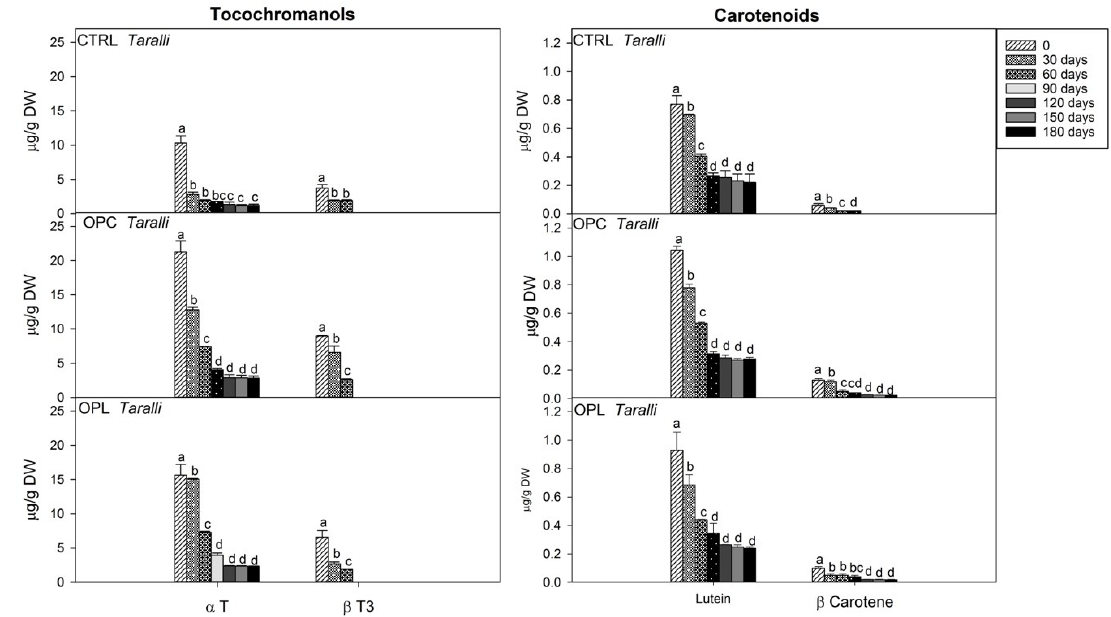
Figure 4. Time course of the amounts of tocochromanols and carotenoids during the storage of CTRL and taralli enriched with the fermented olive paste from Cellina di Nard ò (OPC) or Leccino (OPL) olive cultivars at 25 ◦ C, 500 lux, and in clear plastic bag for 180 days. Data are the mean ± standard deviation of three independent replicates ( n = 3). Data were submitted to one-way analysis of variance (ANOVA), Tukey’s test was applied to compare the experimental times (0, 30, 60, 90, 120, 150, 180 days) within the same sample for each compound ( α -T ( α -tocopherol), β -T3 ( β -tocotrienol), β -carotene, and lutein). Di ff erent letters mean significant di ff erence at p < 0.05.